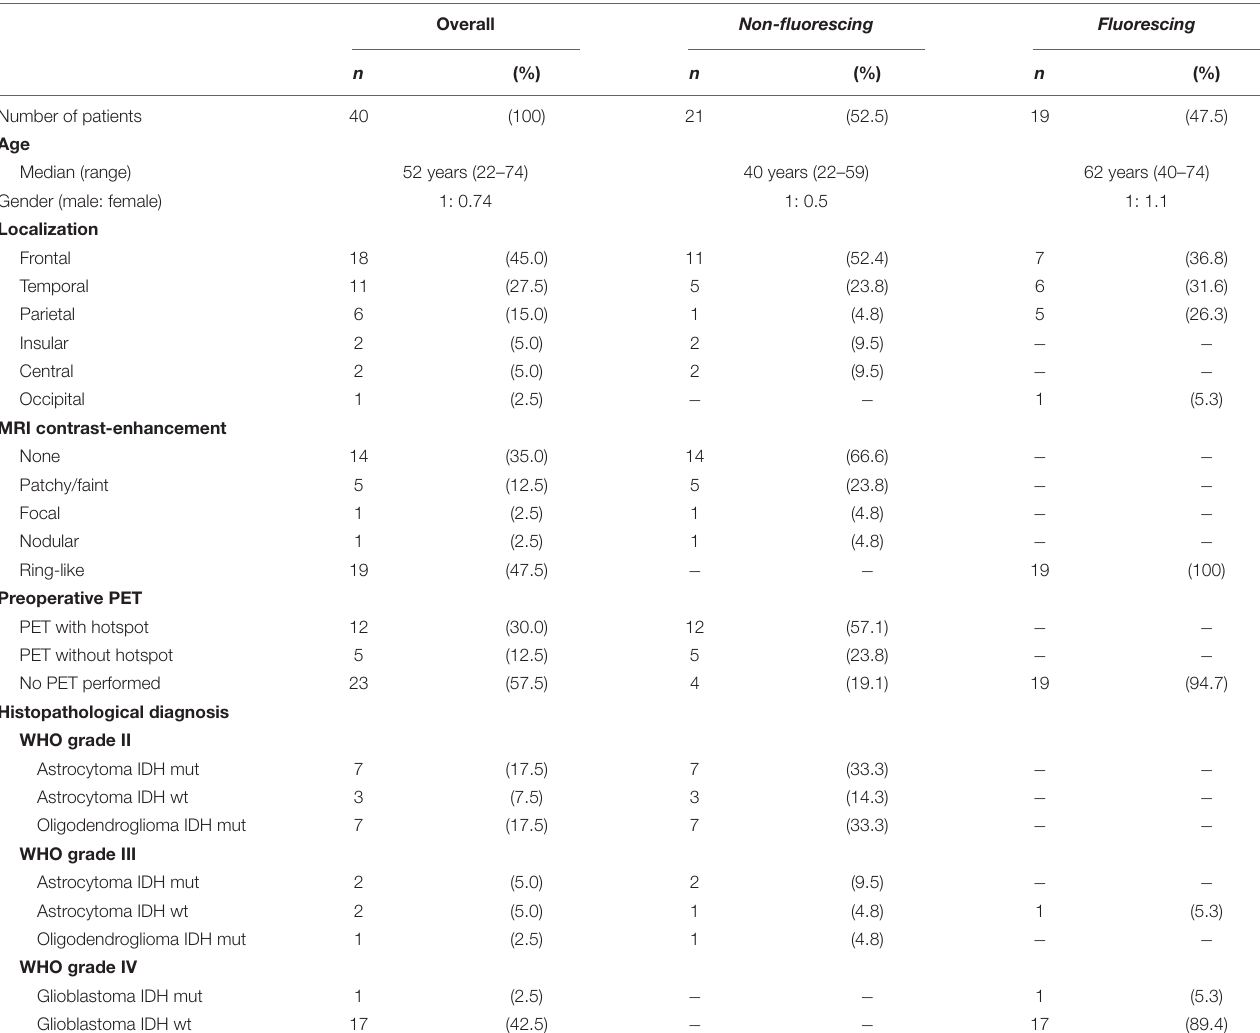
TABLE 1 | Patient